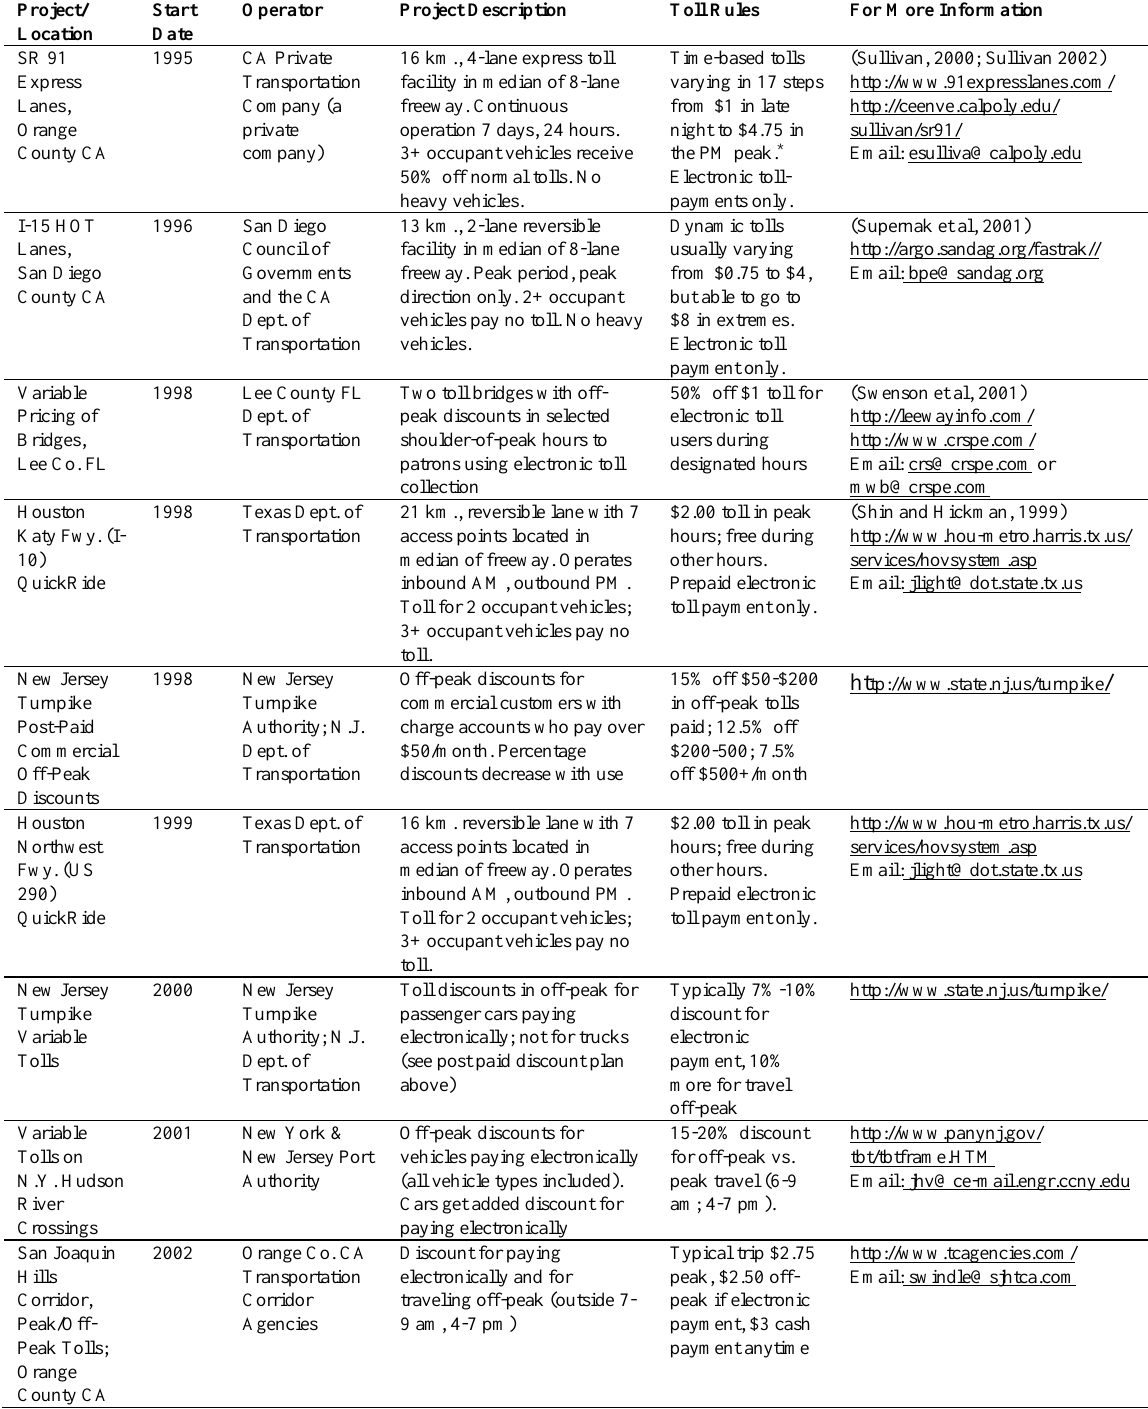
Table 1. Summary of Operational Value Pricing Projects in the